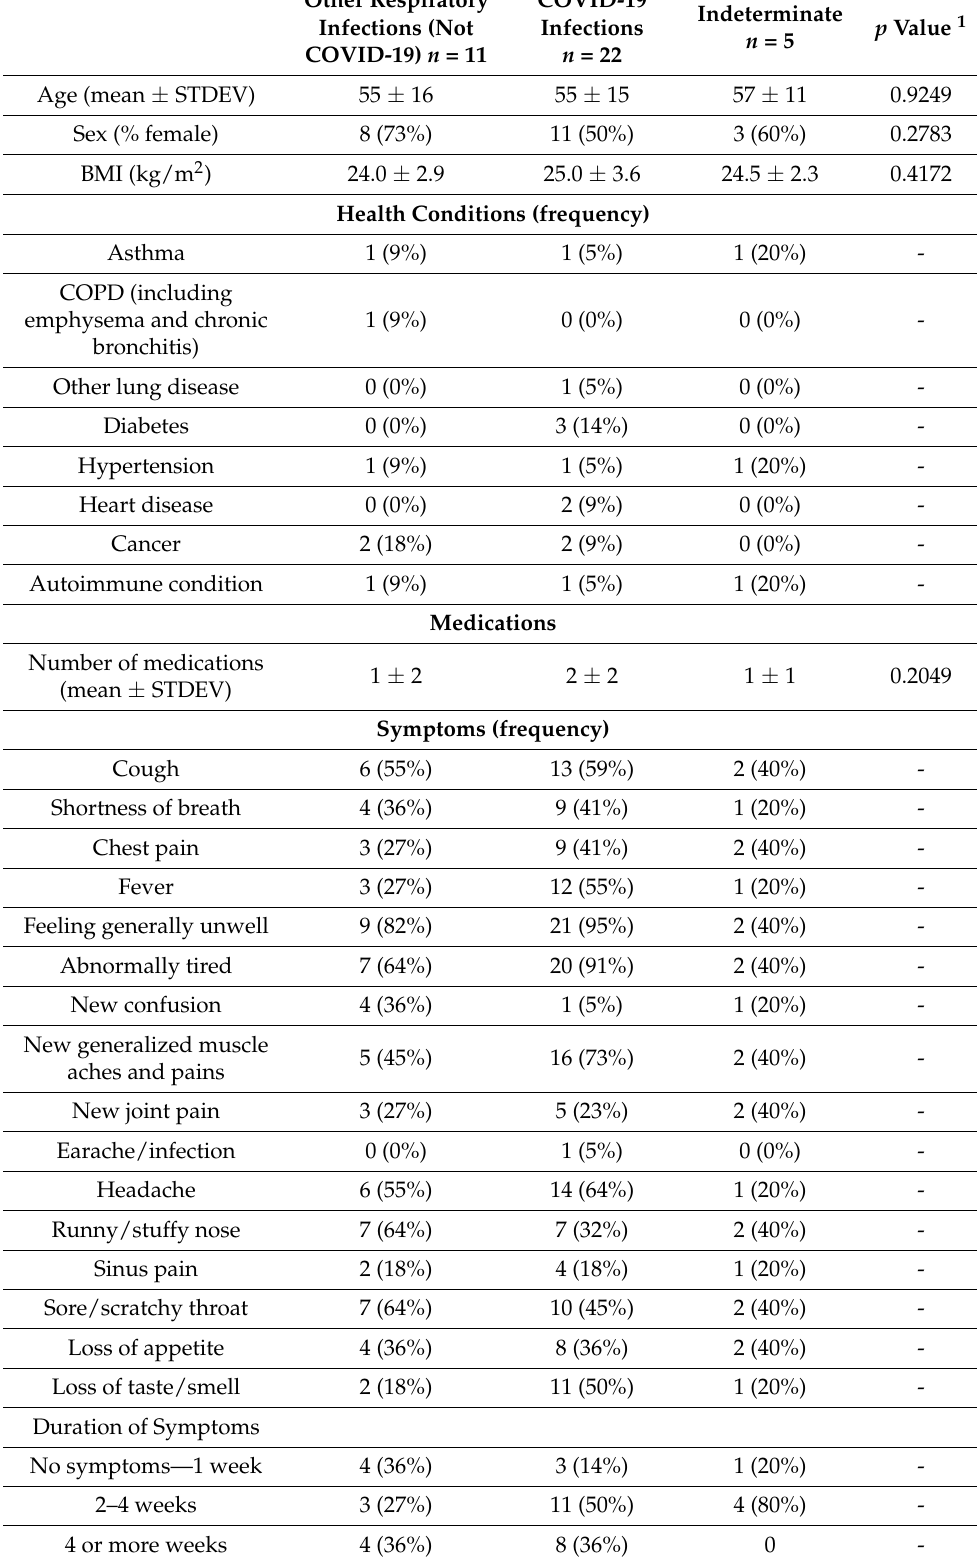
Table 1. Participant demographics 1